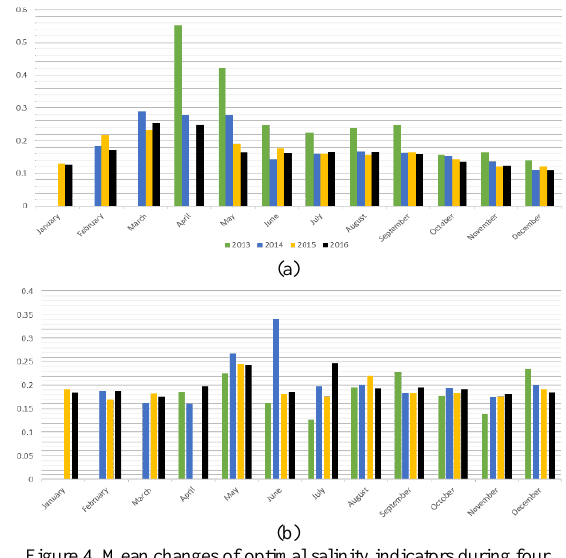
(b) Figure 4. Mean changes of optimal salinity indicators during four years: (a) EVI vegetation index and (b) SI-1 salinity index 3.6 Fitting the best line to corresponding pixels and generate slope index map represent the same area in the scene, therefore, a trend line can be drawn for each pixel through 17 points and slope map of each indicator will be created using trend line slopes. These slopes to land cover variations of both vegetation and bare soil lands